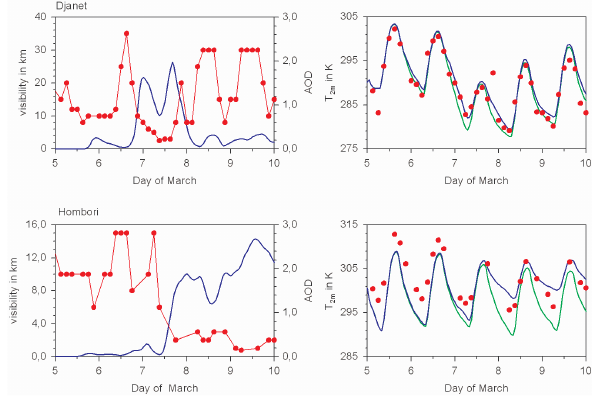
Figure 4: Simulated (blue) AOD at 450 nm and measured AOD at 440 nm (red) at AERONET stations during 5-10 March 2006. Fig. 4. Simulated (blue) AOD at 450nm and measured AOD at 440nm (red) at AERONET stations during 5–10 March 2006.